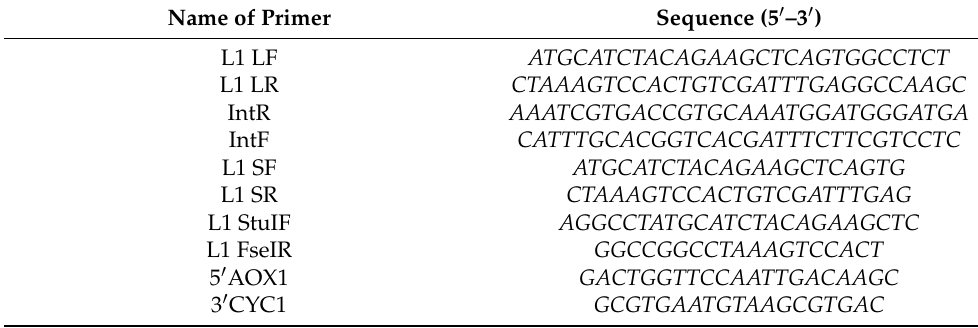
Table 6. Primers used in PCR